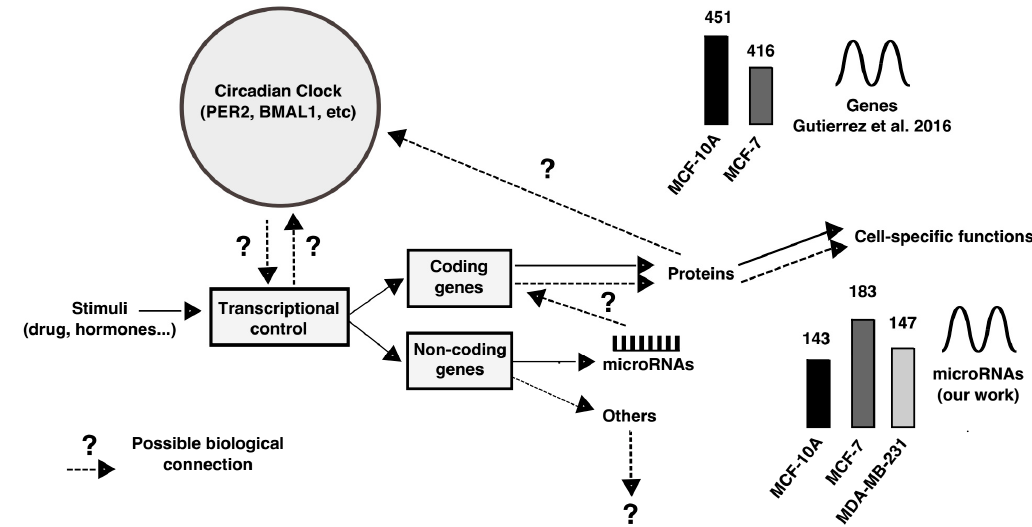
Figure 6. Overview of circadian control and the insight of the rhythmic miRNAs in this system. Continuous lines between concepts represent known facts. Dashed lines represent unknown information. Particularly, derived from our study it is still unknown what could be the role of rhythmic miRNAs to specific cell function and to circadian control. Circadian control inspired in [47].